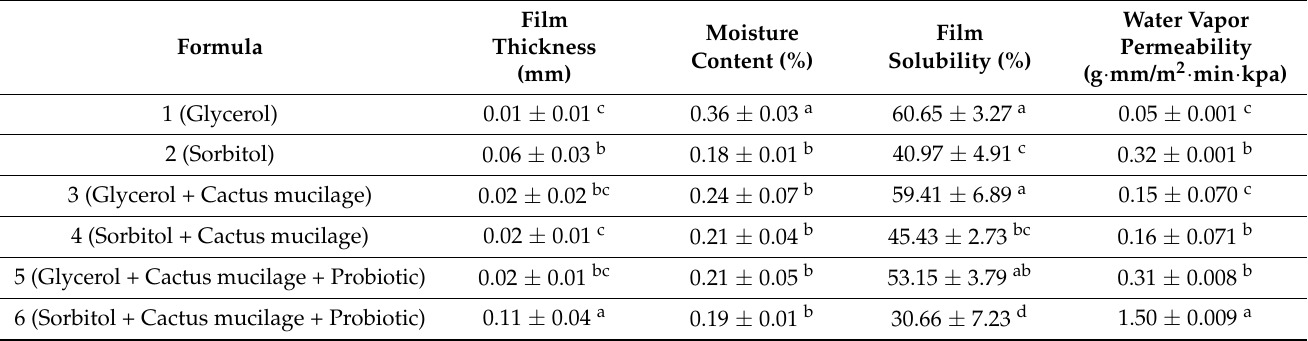
Table 3. Film thickness, percent moisture content, percent solubility and water vapor permeability of the 6 film formulas. The different letters represent a significant difference of p < 0.05. The error bar indicates the standard deviation ( n =